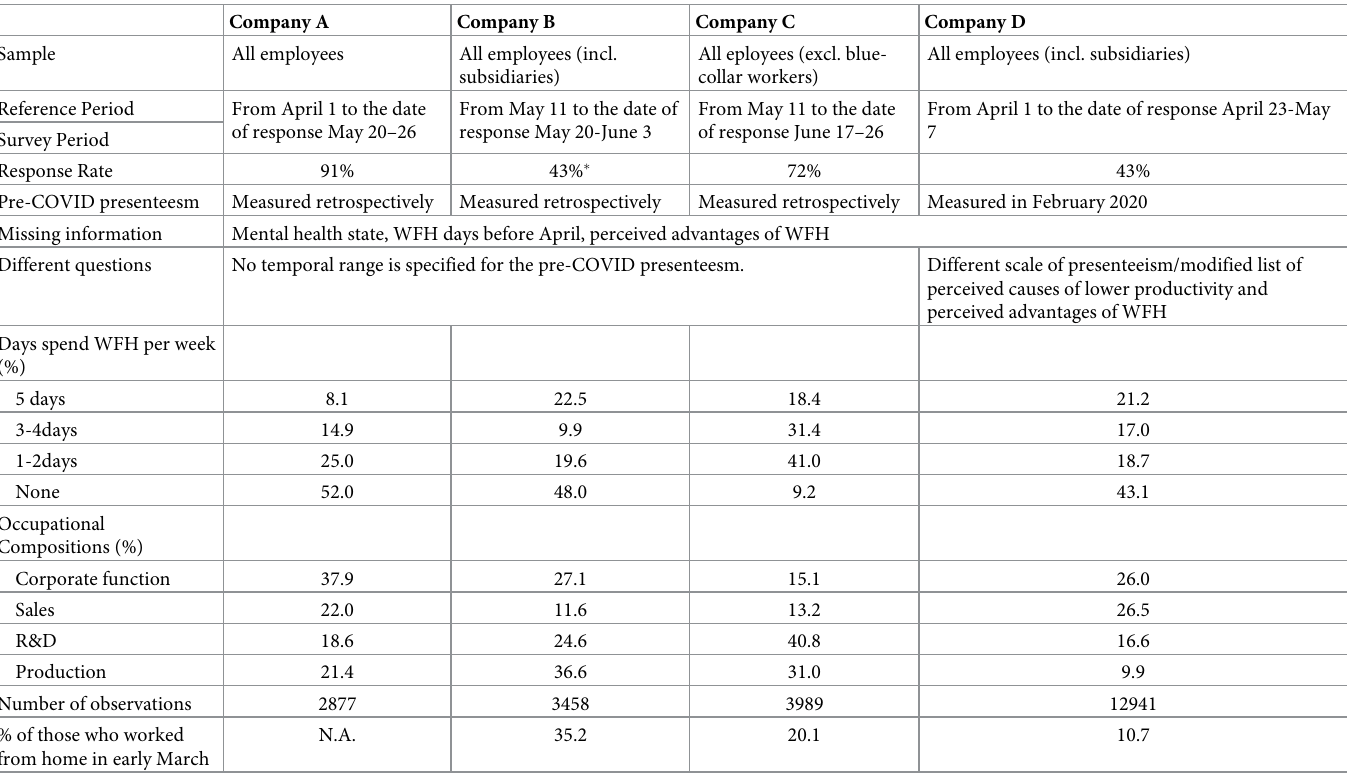
Table 1. Comparison of employee surveys for companies